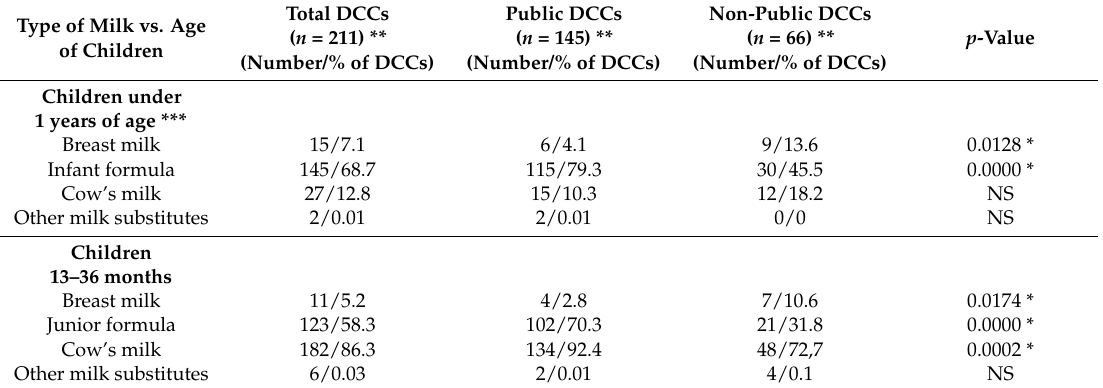
Table 2. Type of milk products and substitutes offered to children in nurseries considering the age and type of day-care centers